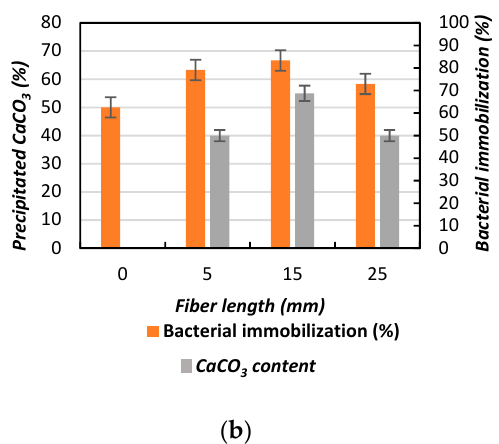
Figure 15. Effect of bacterial immobilization on the CaCO 3 content with the addition of jute fibers: ( a ) fiber content; ( b ) fiber length.